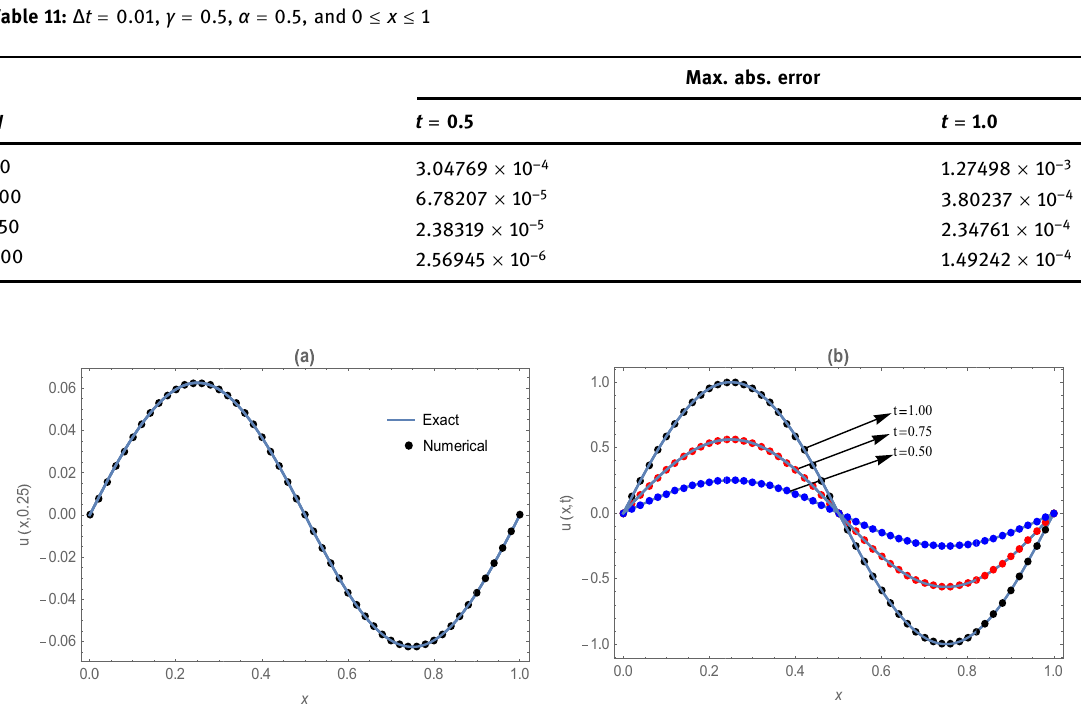
Figure 3: Graphs of approximate and exact solutions for ( a ) t 0.25 = part and ( b ) t 0.50 = , t 0.75 = , and t 1.00 = part.